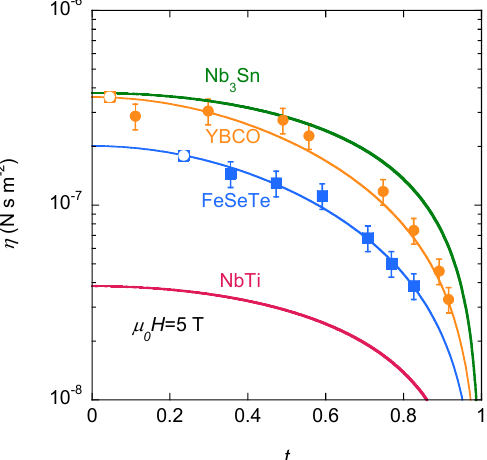
Figure 3. Viscous drag coefficient η measured on YBCO (orange circles) and FeSeTe (blue squares) at 5 T in ZFC as a function of the reduced temperature t . The measured data are approxi- mated with η ( t ) = η ( 0 )( 1 − t 2 ) / ( 1 + t 2 ) [46], with η ( 0 ) = 3.59 × 10 − 7 N s m − 2 for YBCO and η ( 0 ) = 2.02 × 10 − 7 N s m − 2 for the FeSeTe sample. The empty square symbols represent the points extrapolated from the fit at 4 K (which will be used in the next elaborations). The green and red curves represent η ( t ) obtained by considering η ( t ) = Φ 0 B c 2 ( t ) / ρ n (from ρ f f = ρ n B / B c 2 and η = Φ 0 B / ρ f f ) for Nb 3 Sn and NbTi, respectively.